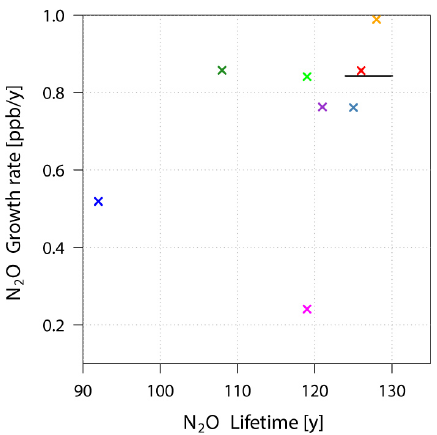
Fig. 3. Modelled and observed N 2 O growth rates (ppb/y) ver- sus lifetimes (y). Legend: Mozart4, yellow; ACTMt42l32, blue; ACTMt42l67, green; TM5, grey-blue; TM3-NCEP, purple; TM3- ERA, red; LMDZ4, magenta; TOMCAT, dark green; observed (cov- ering the range of estimated lifetimes), black